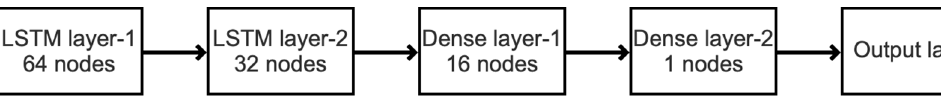
Figure 4. Network structure of the Deep-LSTM network.